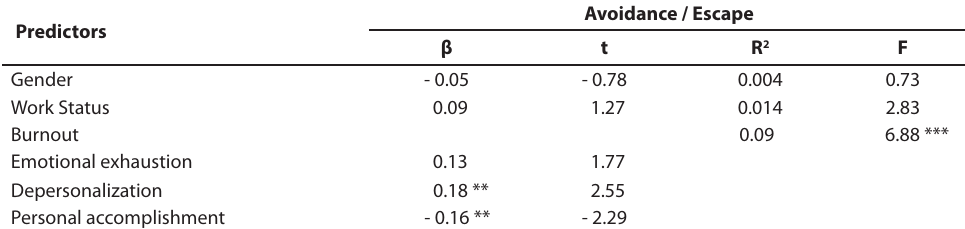
TABLE 4 Regression analysis of Avoidance/Escape strategy from gender, work status and MBI-GS questionnaire factors